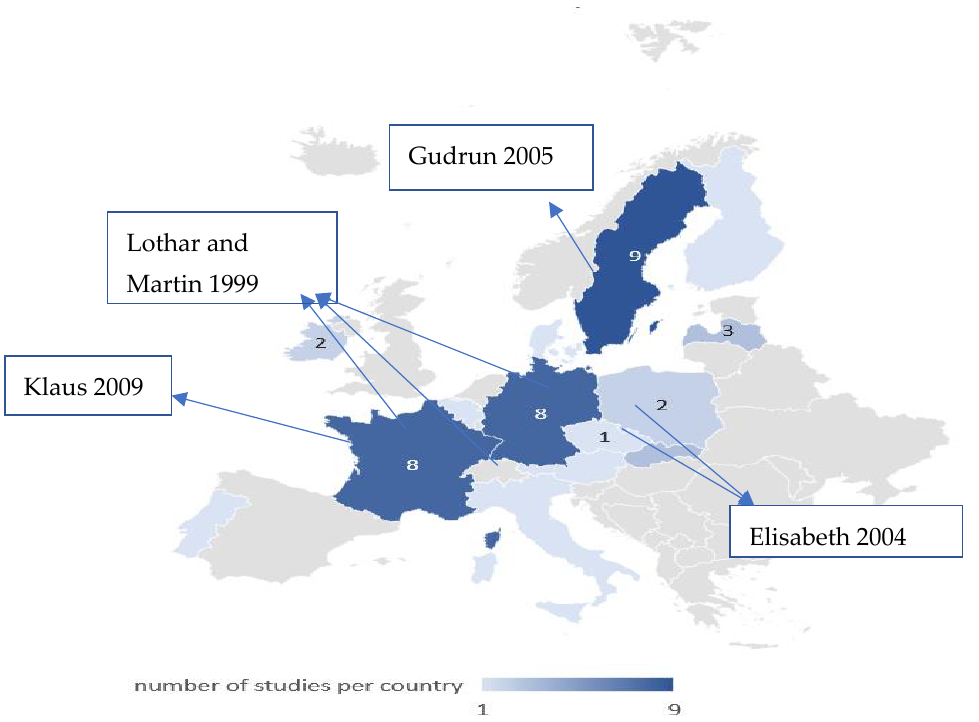
Figure 4. Distribution of studies reviewed across European countries. The most relevant storms mentioned in the articles analyzed and the impact year are reported in the squares (source: own elaboration).